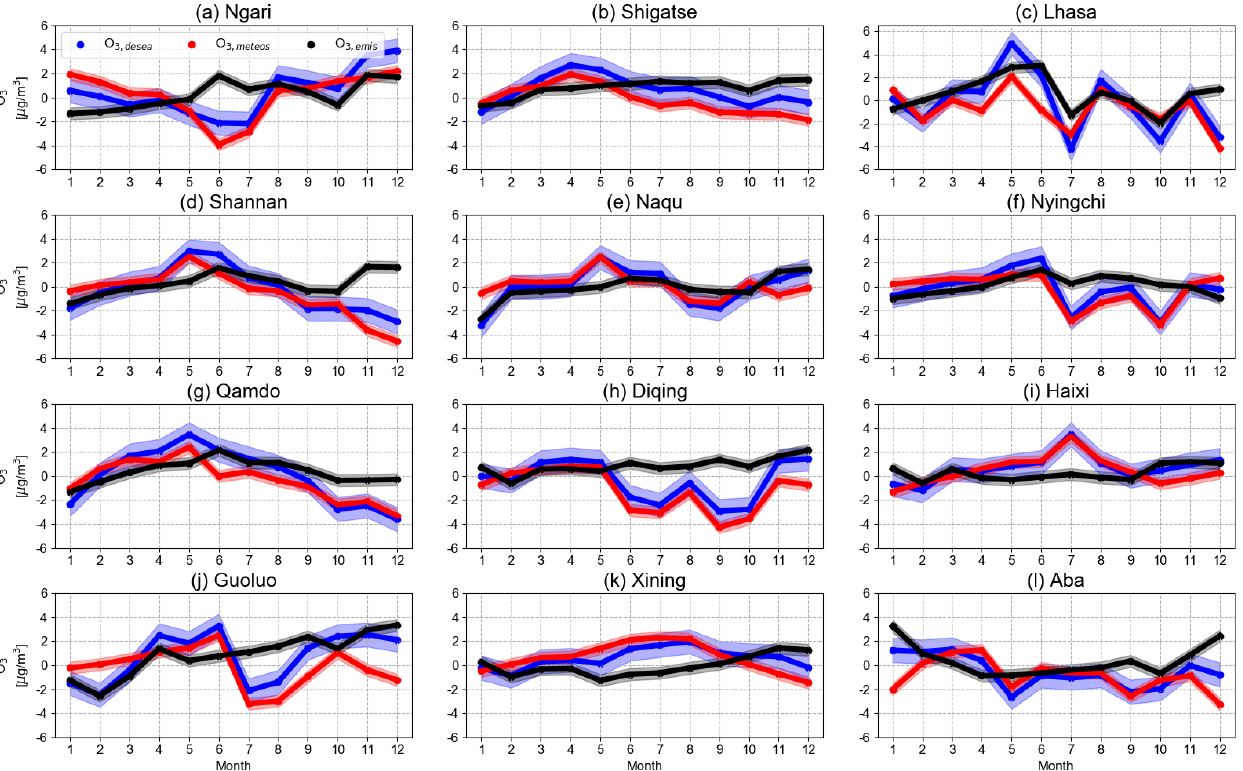
Figure 7. Seasonal cycles of surface ozone anomalies (O 3 , anomalies , blue dots and lines) along with the meteorology-driven por- tions (O 3 , meteo , red dots and lines) and the anthropogenic-driven portions (O 3 , emis , black dots and lines) in each city over the QTP. Bold curves and the shadows are monthly mean values and the 1 σ standard variations